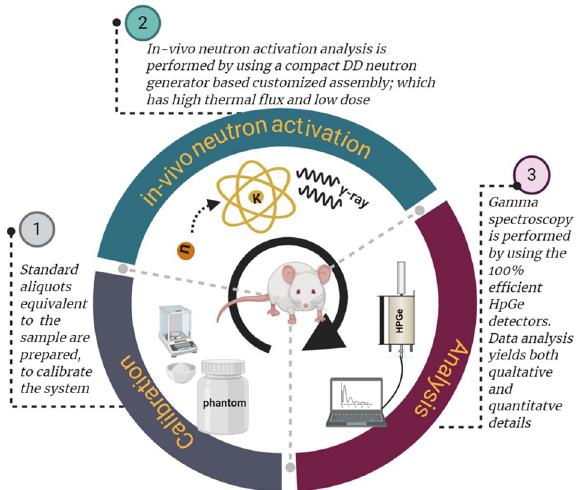
Figure 10. Schematic layout of the steps used for the neutron activation analysis, starting with preparation of standard phantoms for calibration, then with samples placed in the irradiation assembly, and finally with data collected using a high purity germanium system [created with BioRender.com (https:// app. biore nder.